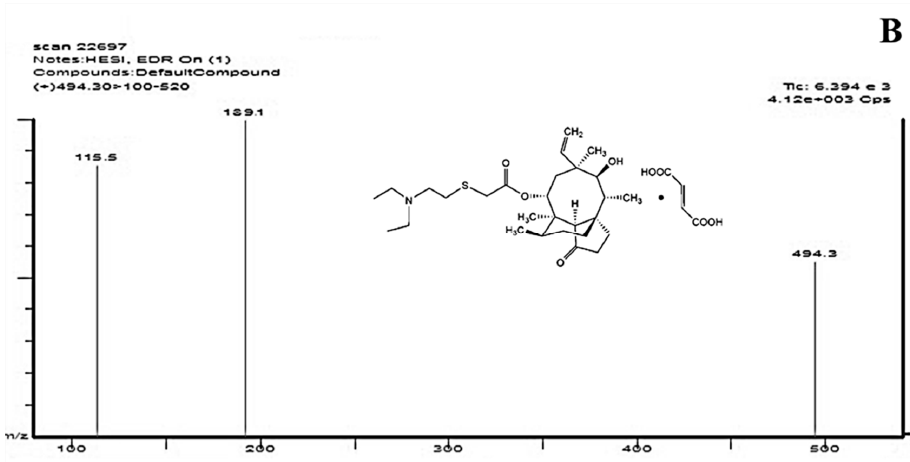
Figure 1. Structures and mass spectra of DPTM ( A ) and tiamulin fumarate ( B ).